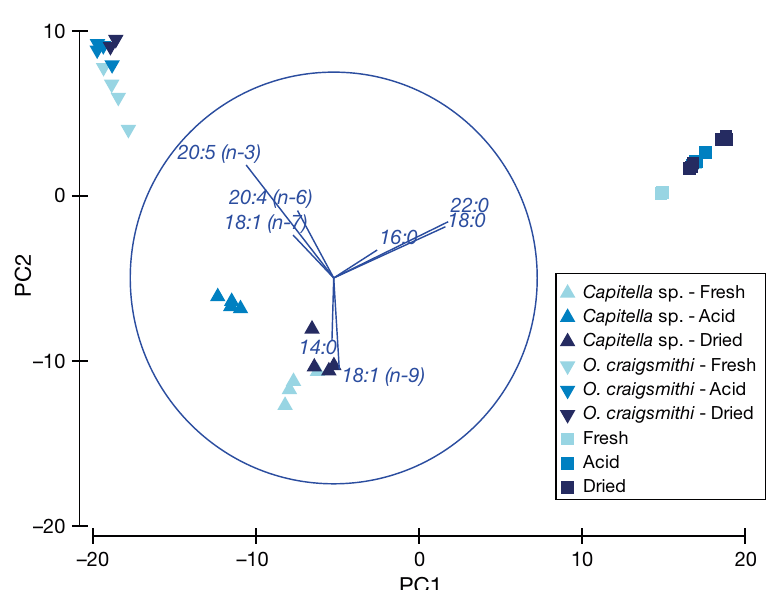
Fig. 4. Principal component analysis (PCA) run with FA profiles of all sample types (see Tables 3 & 4 for FA profiles) including the polychaetes ( Capi tella sp. and Ophryotrocha craigsmithi) and the diets (fresh, acid-preserved and oven- dried). PCA was run on untransformed data. Vectors show correlations of chaetes (>30%), including the FAs essential for fish.